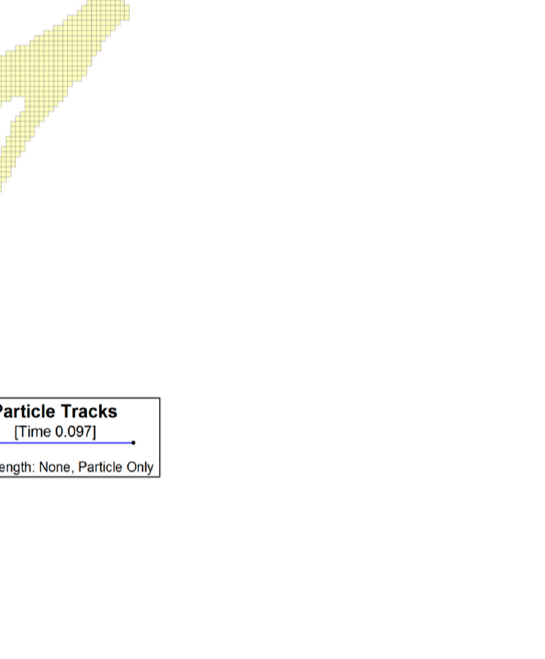
Figure 5. Influence range of oil slick drift in an oil spill accident (when the oil slick drifts out of the water intake).